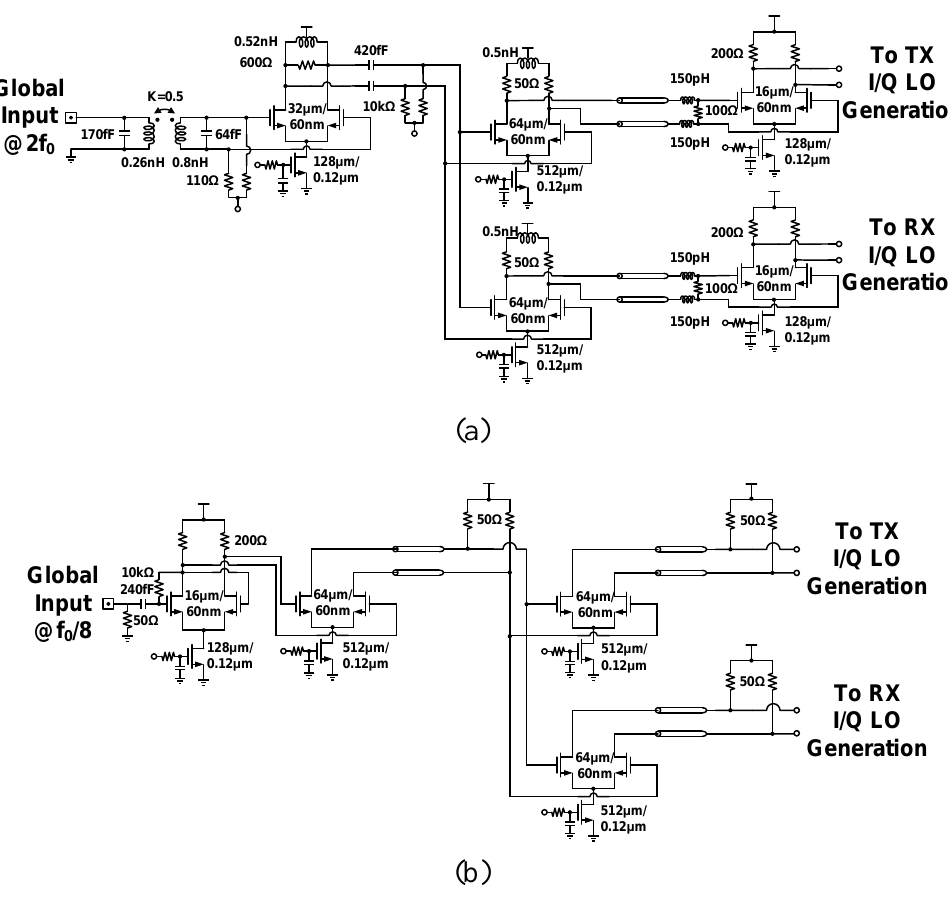
Figure 9. Circuit schematic of the clock distribution network composed of ( a ) 2 f 0 LO buffer chain and ( b ) f 0 /8 LO buffer